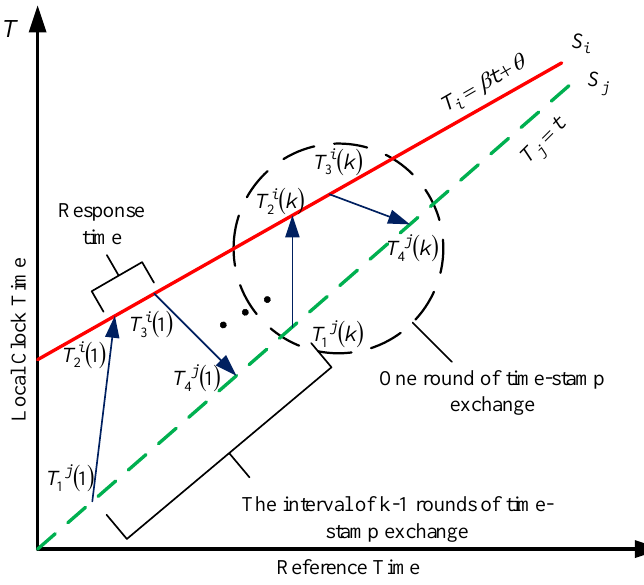
Figure 1. Two-way timing message exchange